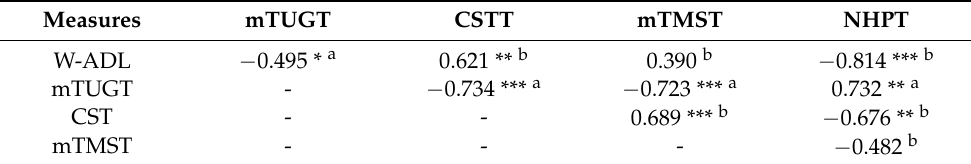
Table 4. Correlation between daily functioning and functional abilities.